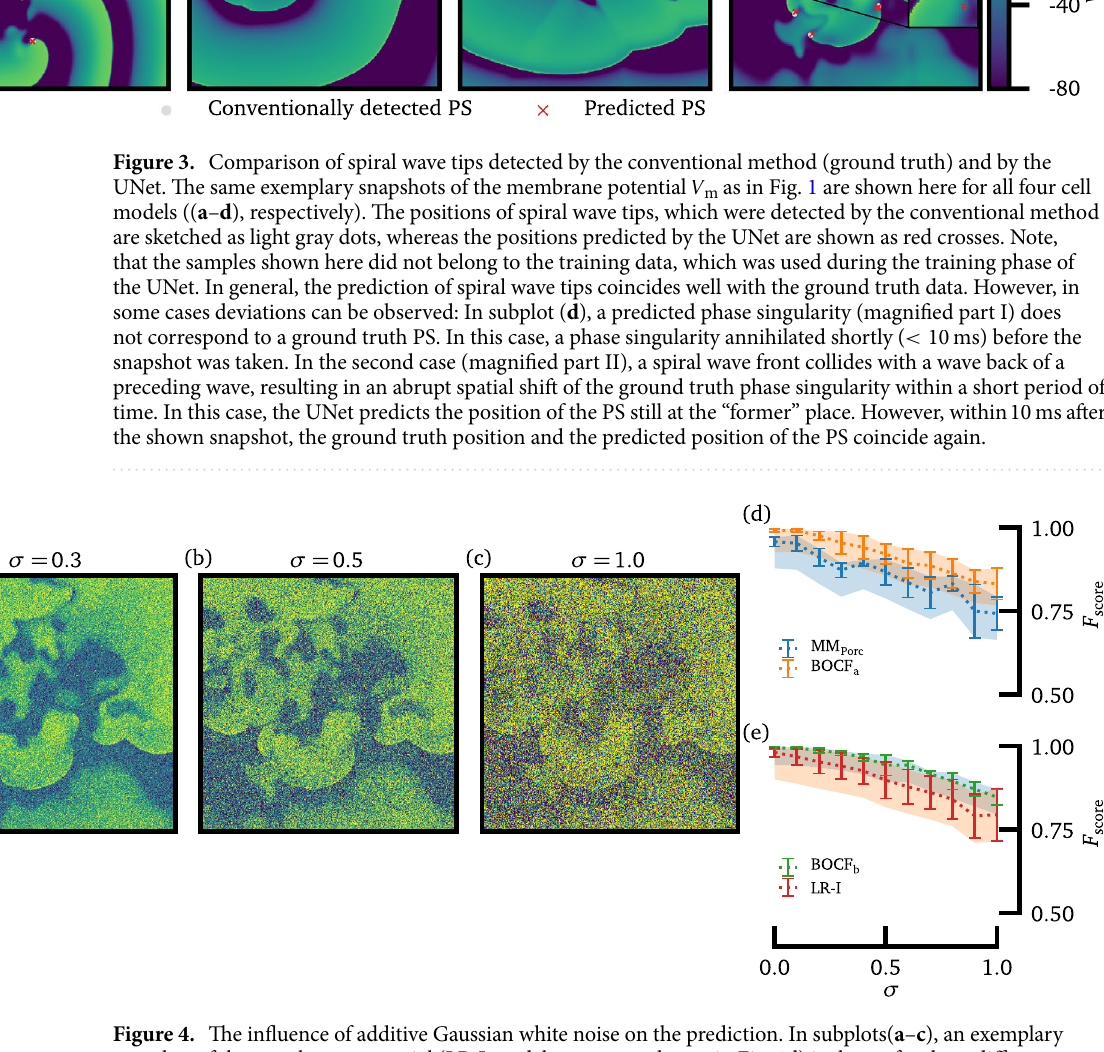
Figure 4. The influence of additive Gaussian white noise on the prediction. In subplots( a – c ), an exemplary snapshot of the membrane potential (LR-I model, same snapshot as in Fig. 1d) is shown for three different values of the standard deviation of the Gaussian distribution σ = 0.3, 0.5, 1.0, respectively. In subplots ( d ), and ( e ) the F score is depicted for all four investigated models, depending on σ